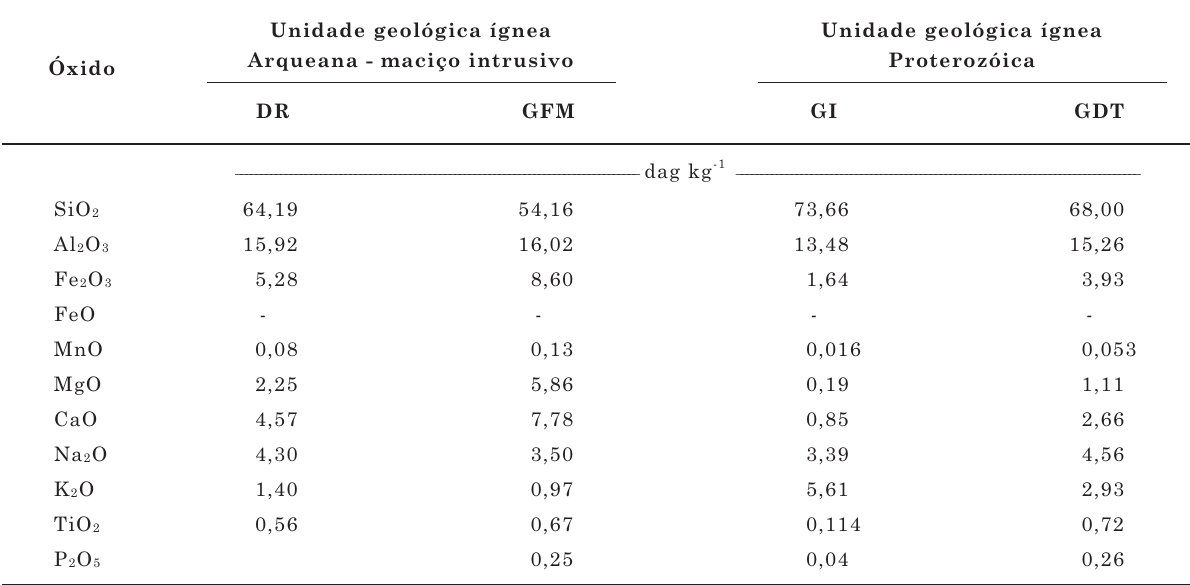
DR: Diorito do Rosário; GFM: Gabro da Fazenda Martins; GI: Granito de Itutinga; GDT: Granodioritos Transamazônicos. Fonte: Quéméneur